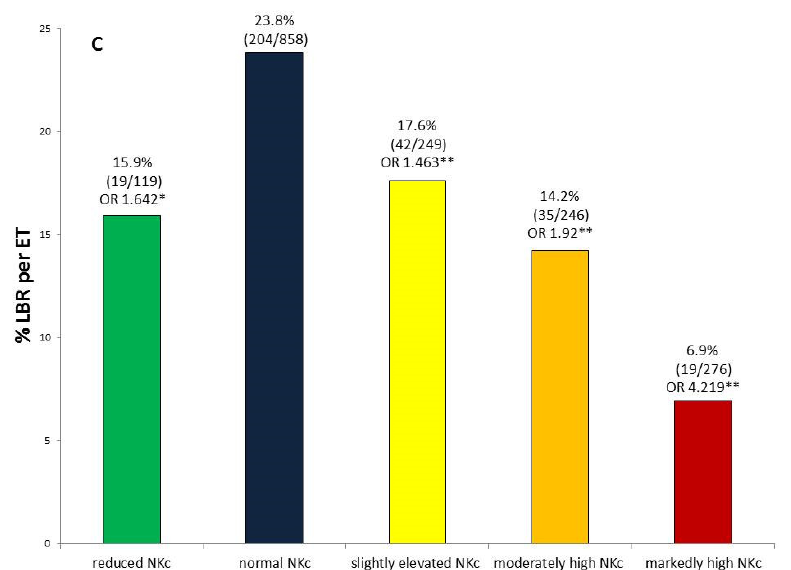
Figure 1. ( A ) Implantation rate (IR), ( B ) Clinical pregnancy rate (CPR) and ( C ) Live-birth-rates in patients with different NK cytotoxicity levels. IR, CPR andLBR was calculated per ET. (* p = 0.06 compared to patients with normal NKc. ** p < 0.05 compared to patients with normal NKc).